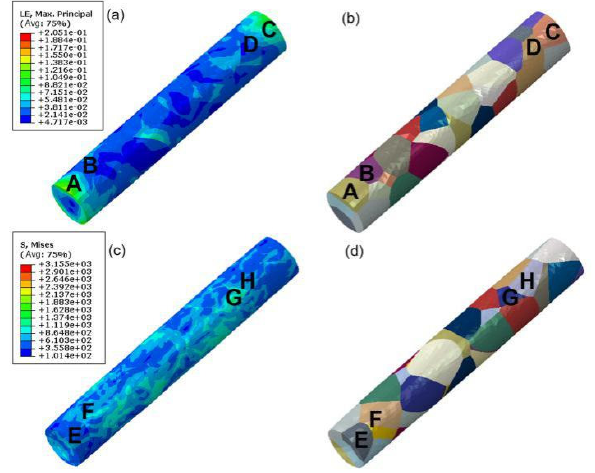
Figure 10. ( a , c ) Strain and stress distribution and ( b , d ) polycrystalline model.